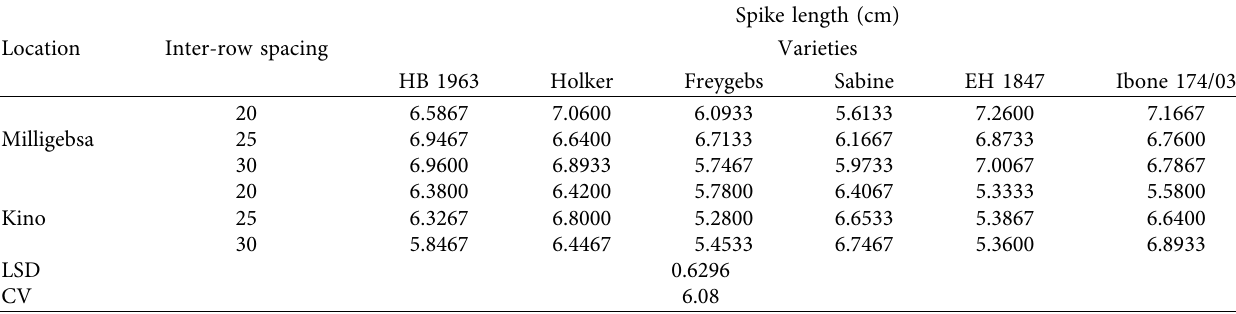
Table 5: Interaction effect of varieties, inter-row spacing, and location on spike length of malt barley at Debark, north Gondar, Ethiopia, in